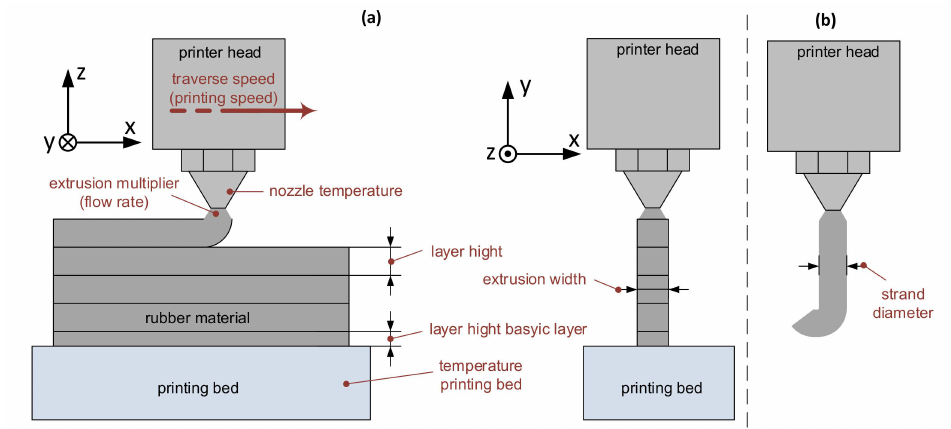
Figure 2. ( a ) Visualization of the parameters to be set for 3D printing and ( b ) discharge of the rubber material out of the nozzle, for measuring the strand